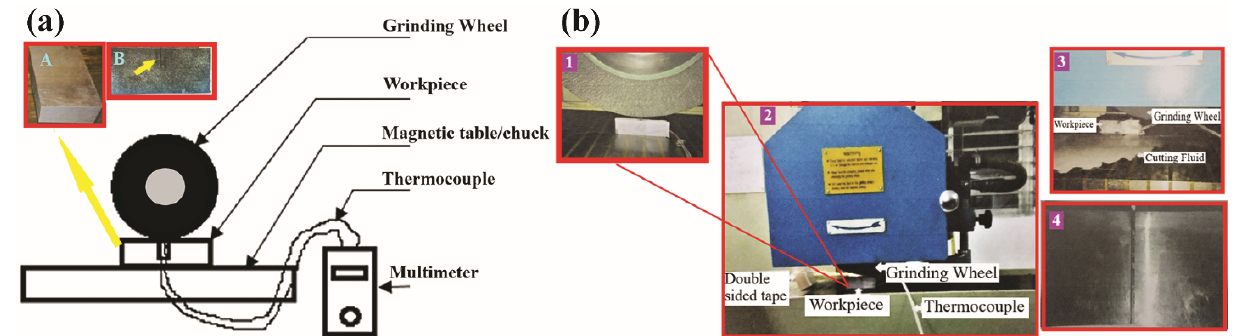
Figure 3. ( a ) Schematic diagram of the experimental setup where inset A and B shows photograph images workpiece before slot cutting and after slot cutting using wire EDM, and ( b ) pictorial view of the experimental setup. A—Workpiece before machining. B—Wire cut on the workpiece. 1—Thermocouple setup on the workpiece. 2—Dry machining setup. 3—Wet machining setup. 4—Workpiece after machining.